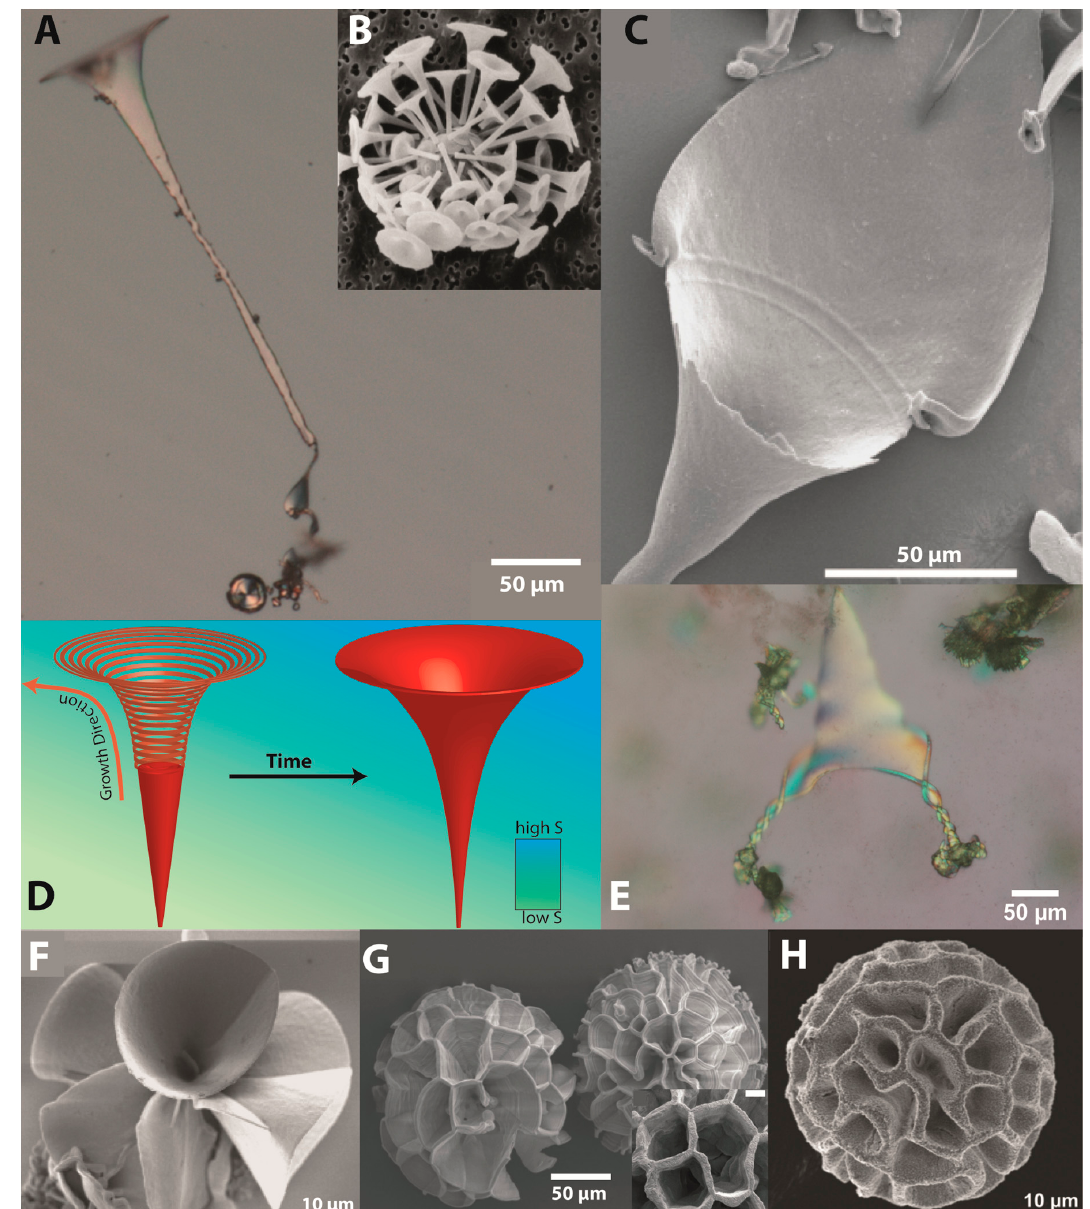
Figure 4. Biomorphs with lifelike morphologies. ( A , C ) PLM and SEM images of biomorphs in the shape of a marine coccolith. Formed from solution, containing 5 mM Ba 2+ and 9 mM silica at 40 °C. ( B ) SEM image of a natural marine coccolith (Reproduced with permission from ref. [24], Copyright 2012 Wiley-VCH Verlag GmbH & Co KGaA). ( D ) Schematic illustration of the formation process of coccolith morphologies illustrating the supersaturation gradient into the solution. ( E ) PLM micrograph of a biomorph structure grown at higher temperature (40 °C) showing a trumpet structure exfolding into two helicoidal structures. ( F ) SEM micrograph of a flower-like biomorph grown from a 5 mM Ba 2+ solution containing alkaline silica sol at 50 °C. ( G ) SEM micrograph of a coral-like biomorph structure grown at higher Ba 2+ concentration (250 mM; scale bar of the inlet: 10 µm) ( H ) SEM micrograph grown from a 5 mM Ba 2+ solution containing alkaline silica sol with 1 mM La 3+ ions.